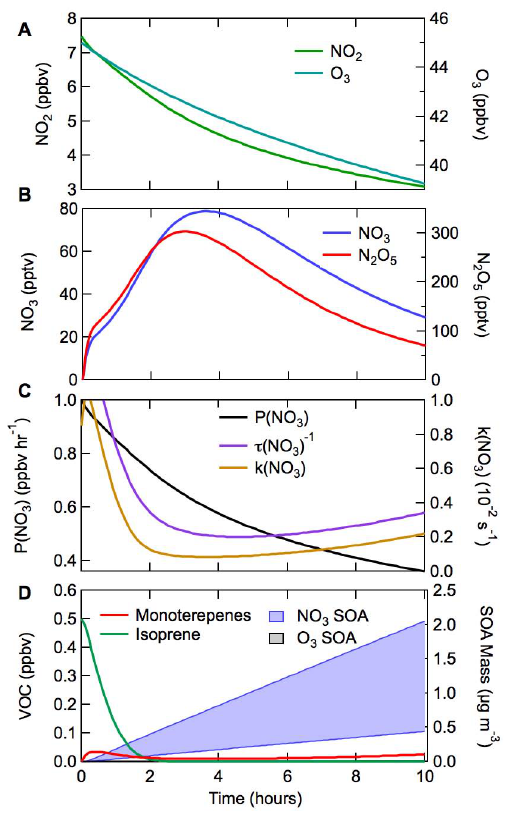
Fig. 18. Same as Fig. 17, except for smaller nitrate radical and BVOC emission rates intended to represent biogenic VOC oxida- tion over the urban area (see